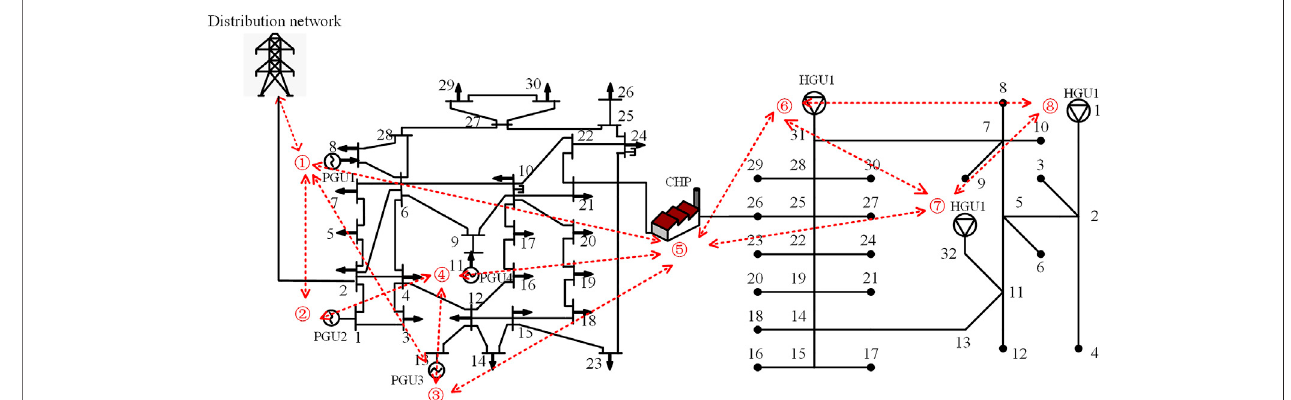
FIGURE 3 | The schematic of 30 – 32 nodes IES.